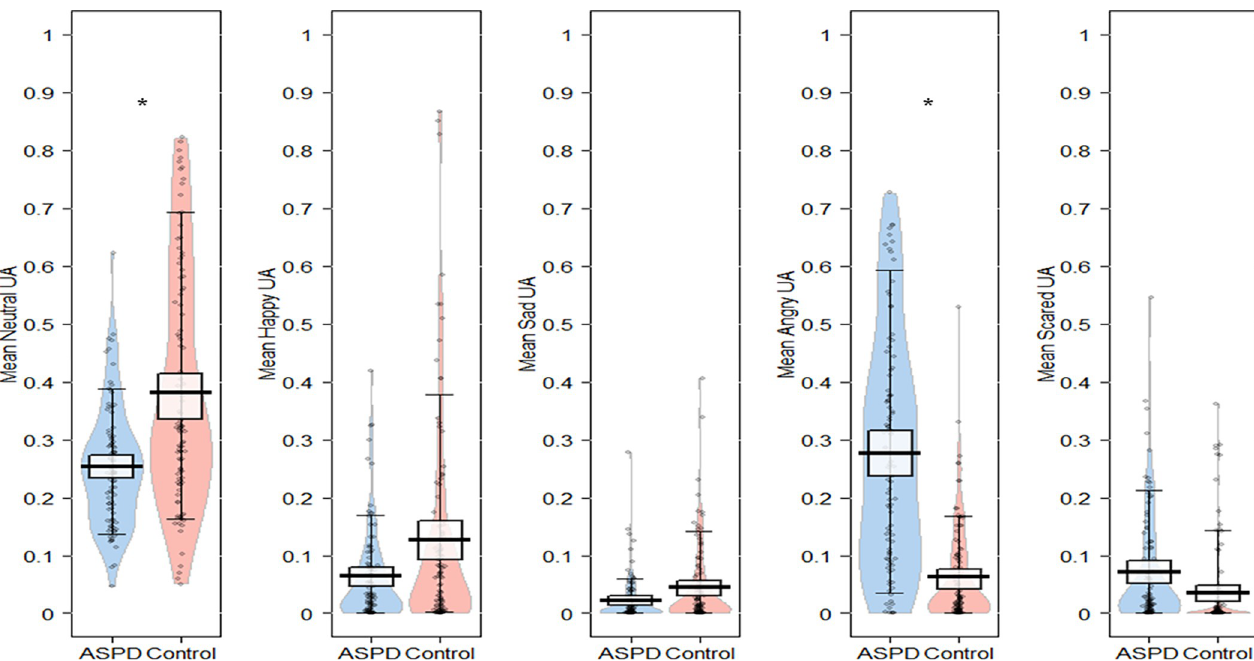
Fig 1. Pirateplot of activation of action units per SDM in ASPD and healthy control groups. Gray points correspond to raw data, beans correspond to the density of distributions, thick vertical bars correspond to central tendencies of distribution and rectangle to 95% Bayesian Highest Density Intervals of distributions [50]. � corresponds to a significant result of multivariate beta regression analyses for each category of facial expressions (Model 1).